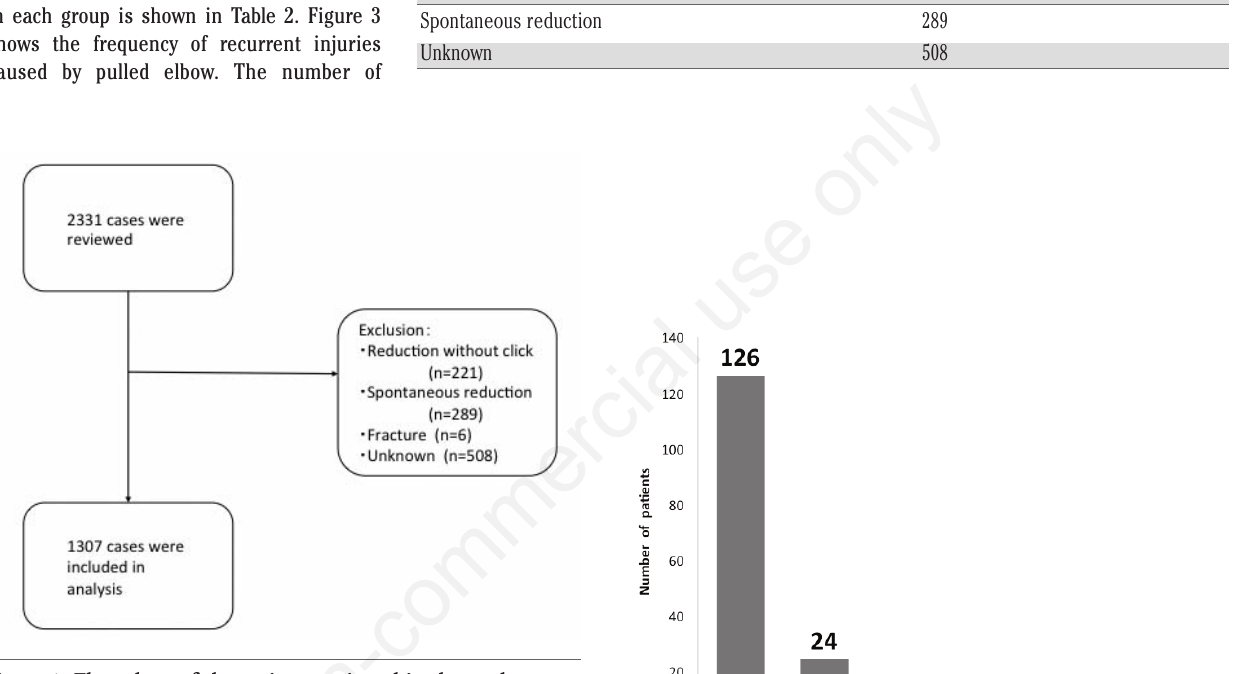
Figure 1. Flow chart of the patients reviewed in the study.